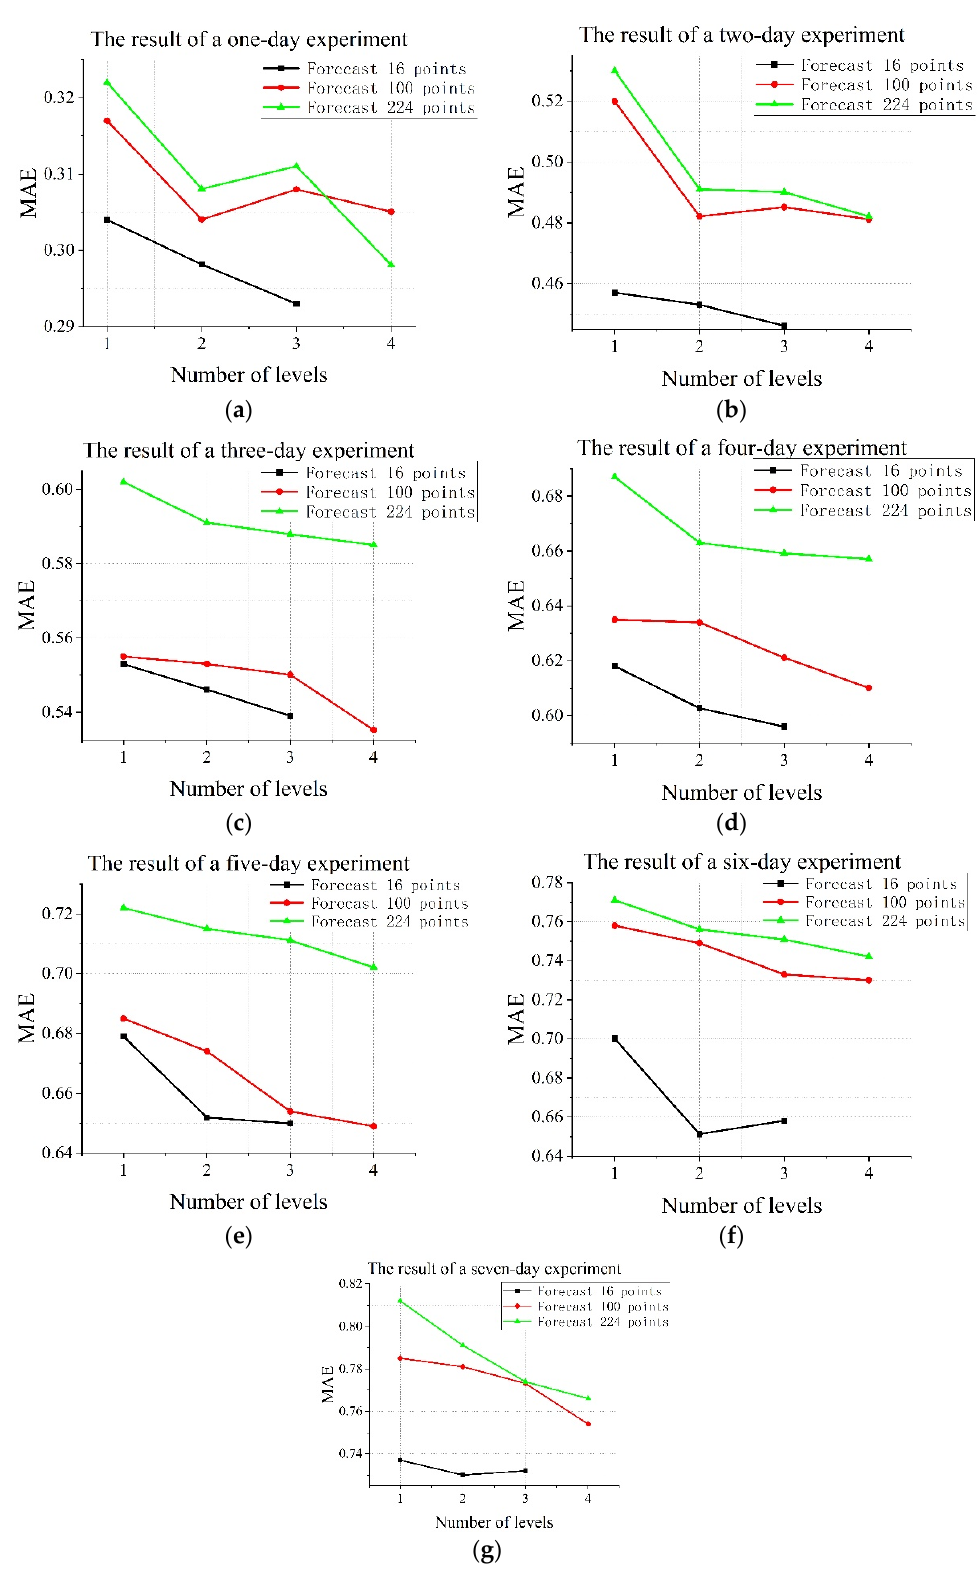
Figure 4. Results of CENS in the Bohai Sea for different levels.